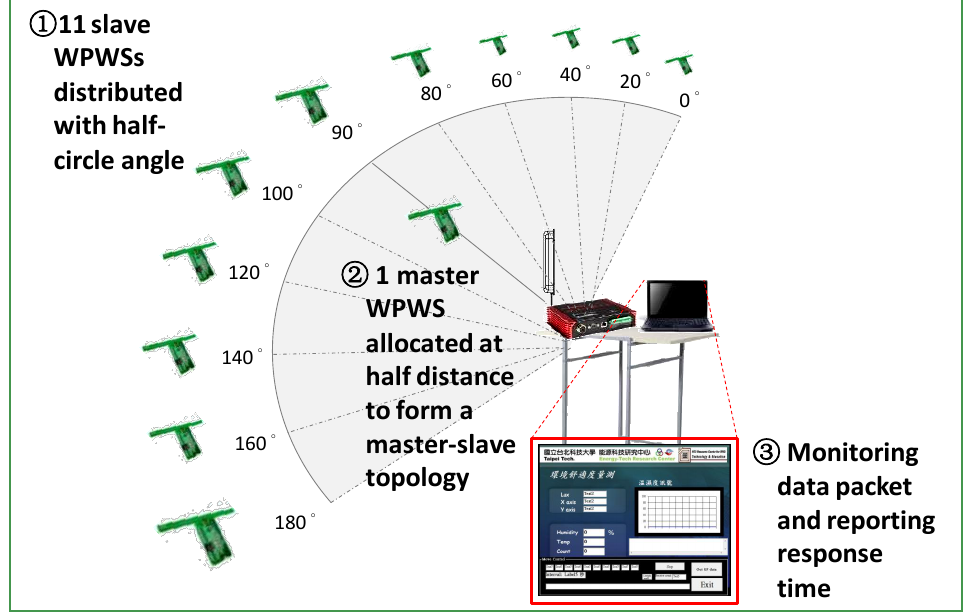
Figure 16. Experimental Setup 3: One WPWS works as a master node and another 11 WPWSs are slave nodes. This arrangement forms a master-slave topology, which